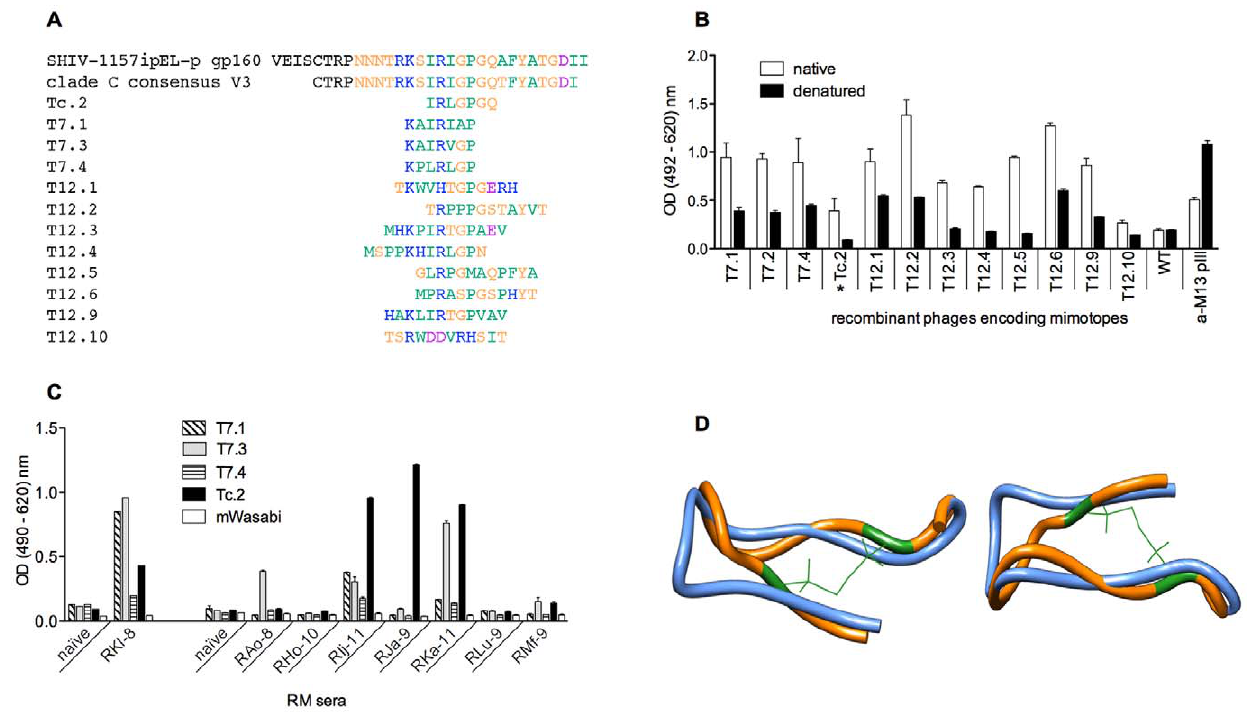
Figure 3. Properties of V3 loop mimotopes. (A) Binding of rhesus monkey RKl-8 serum Abs to native and denatured mimotopes. Wild-type phages (WT) were used as negative control, an anti-phage Ab (anti-M13 pIII) as positive control to show correct phage immobilization. Each data point represents the mean 6 s.e.m. (n =3). *Mimotope selected for B-cell sorting. (B) Sequence alignment of V3 loop region of gp160 and mimotopes isolated by differential biopanning. Amino acid colors indicate: blue, basic; green, non-polar (hydrophobic); orange, polar (uncharged); magenta (acidic). (C) Binding of RM sera to different V3 mimotopes. Plates were coated with mWasabi-mimotope fusion proteins and parental mWasabi as control and then probed with sera of rhesus monkeys with high nAb titers. Serum from monkey RKl-8 served as positive control; serum from a naı¨ve animal was used as negative control in all experiments. Each data point represents the mean 6 s.e.m. (n =3). (D) Structural superimposition of Tc.2 mimotope and V3 peptide obtained by in silico molecular modeling. Tc.2 mimotope was modeled using the published V3 peptide structure in complex with Fab2557 [13]. The original V3 loop is shown in blue, the Tc.2 mimotope in orange. The cysteine residues and disulfide bridge are in